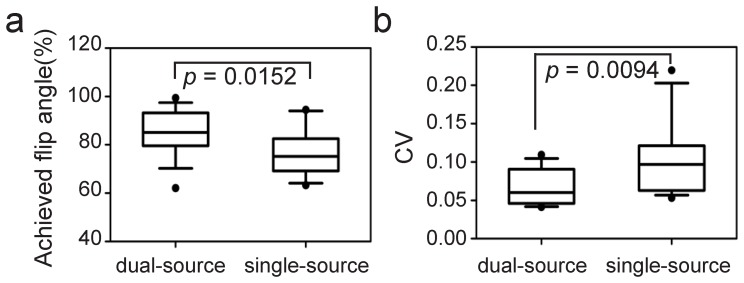
Quantitative assessment of RF field homogeneity.Box-type diagrams showed average percentage of achieved FA (a) and coefficient variance (CV) (b) as a measurement of RF homogeneity for dual-source and single-source. A higher average percentage of FA and a lower mean CV was obtained by using of dual-source mode. Both parameters improved with dual-source from all subjects.